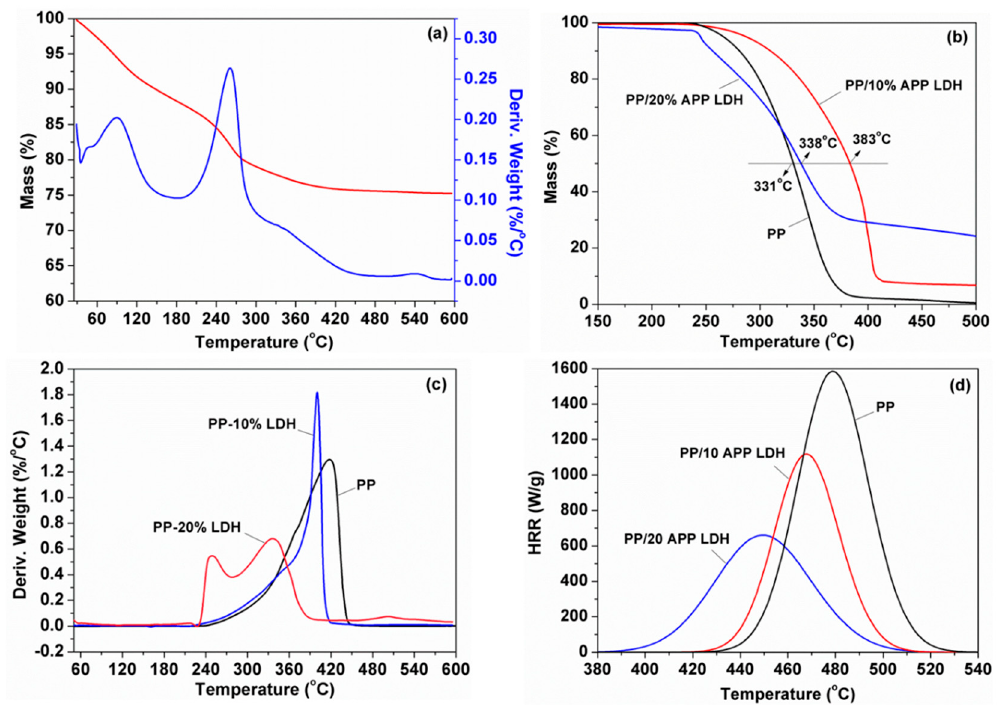
Figure 6. ( a ) Thermogravimetric-differential thermal gravity (TGA-DTG) curve of APP-LDH, ( b ) TGA, and ( c ) DTG curves of pure PP and PP/APP-LDH nanocomposites, and ( d ) microscale combustion calorimeter (MCC) analyses of pure PP and PP/APP-LDH nanocomposites.